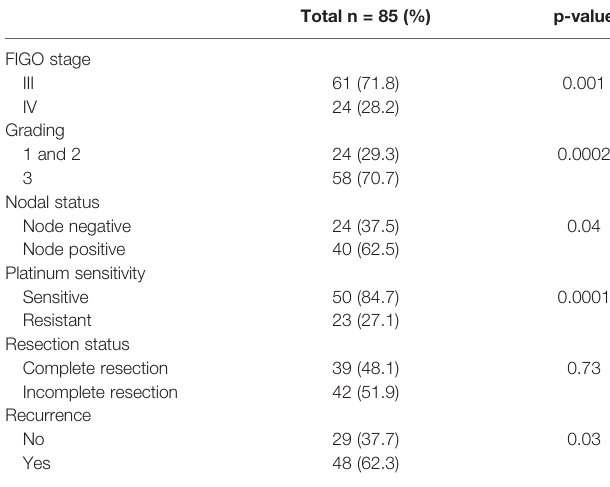
TABLE 1 | Clinical data of patients with advanced EOC at the time of primary